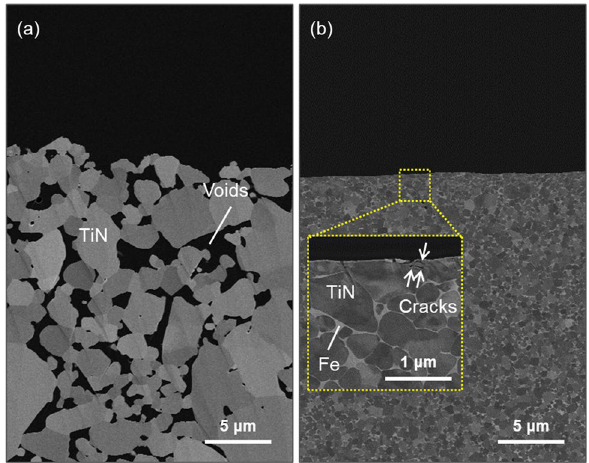
Fig. 1 Cross-sectional SE images of a the TiN solid-phase sintered ceramic and b the TiN liquid-phase sintered ceramic near the sur- face